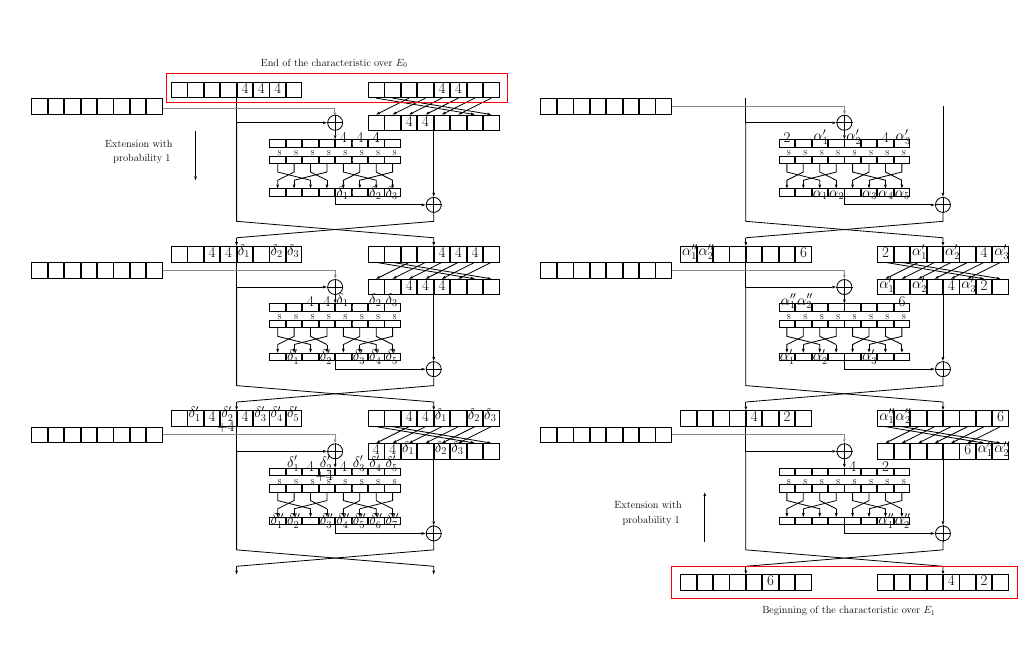
Figure 13: Setting for the switch over three rounds of LBlock-s